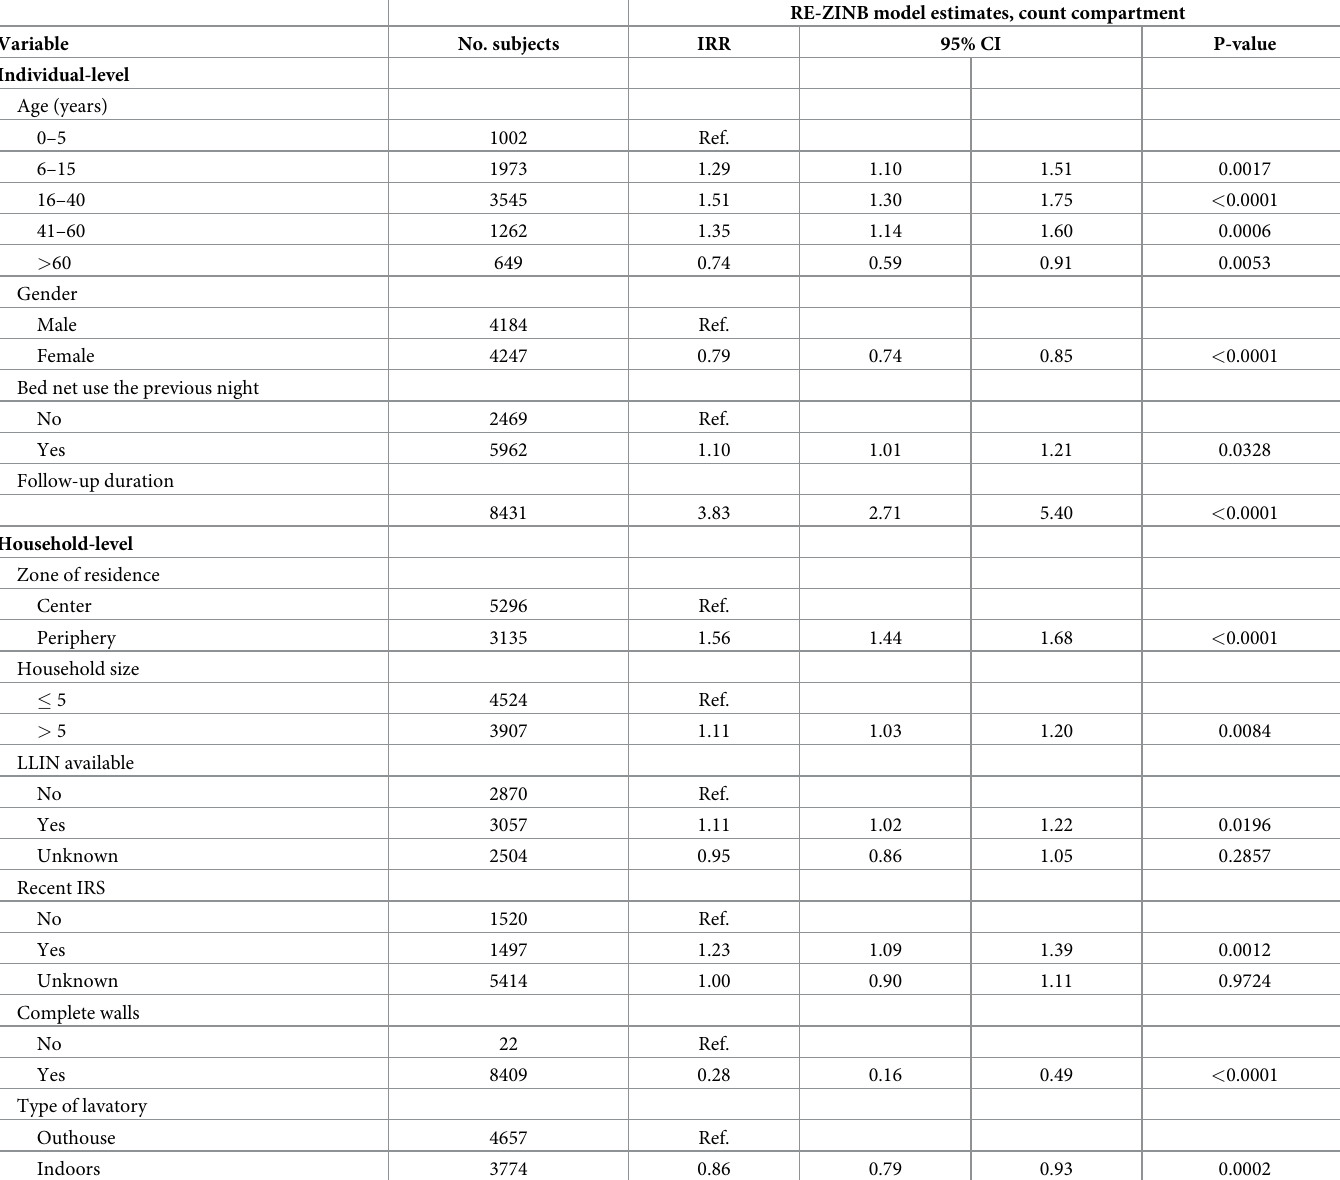
Table 2. Independent predictors of malaria incidence density in urban Maˆncio Lima, Brazil, identified by multivariable random-effects zero-inflated negative bino- mial (RE-ZINB) regression